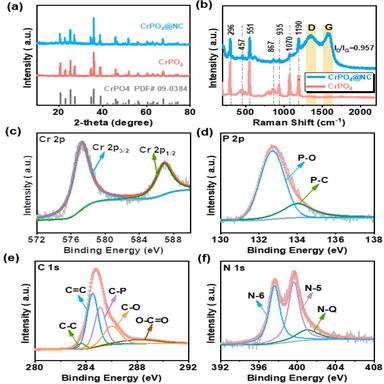
(a) XRD pattern and (b) Raman spectra of CrPO4@NC and CrPO4 samples, (c–f) High resolution Cr 2p (c), P 2p (d), C 1 s (e), and N 1 s (f) XPS spectra of CrPO4@NC composite.